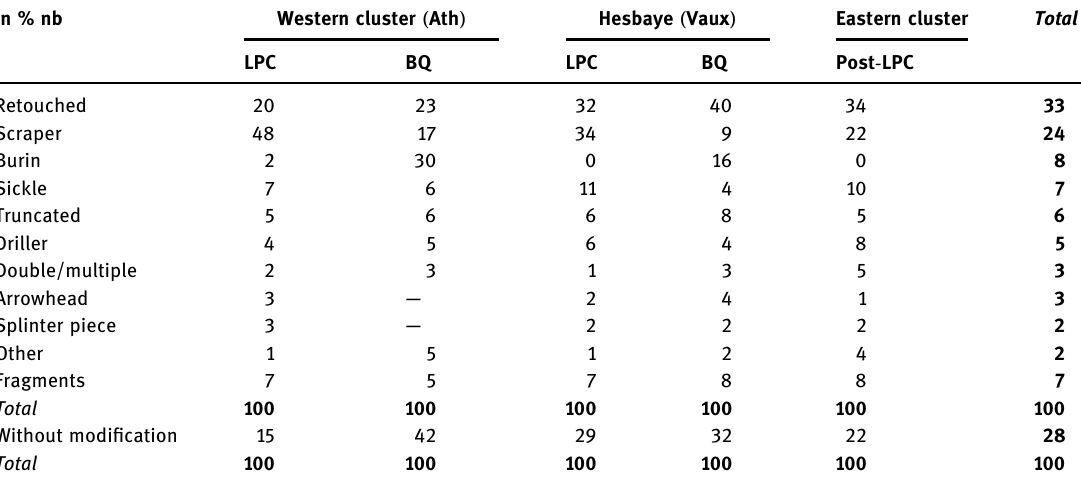
Table 2: Toolkit identi fi ed on the studied blades from the three clusters In % nb